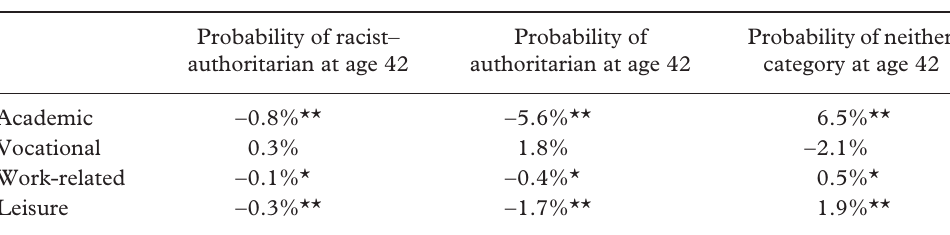
Table 4. Marginal effects of adult learning on those in the ‘neither’ category at age 33